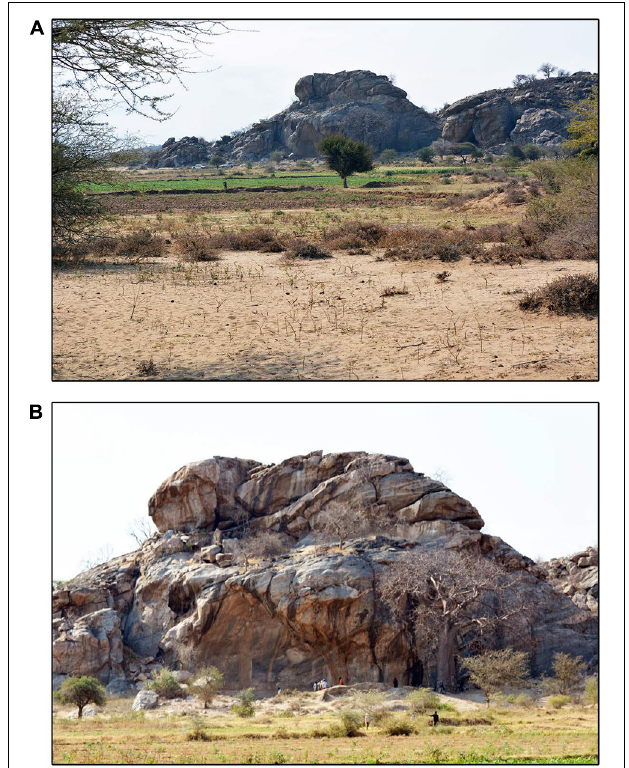
FIGURE 3 | Ground views of the geological outcrop and rock shelter where the site of Mumba is located. (A) From the north, the view reveals the palaeofan from the Barai river. (B) Vegetation today grows all around the rock shelter, up to the dripline.